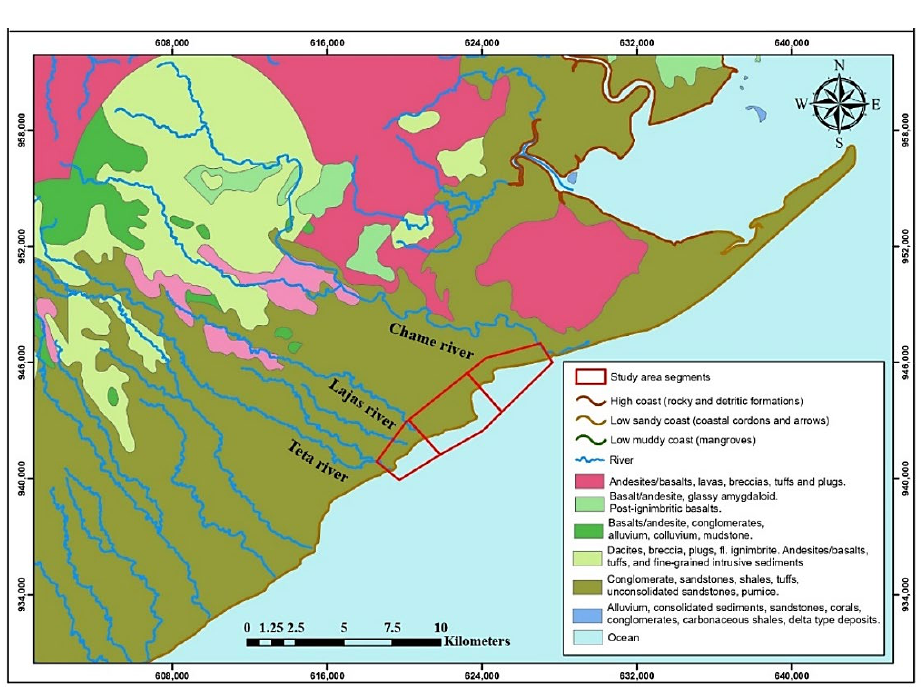
Figure 2. Geological, hydrological, and coast of study zones. Cartography made by Smithsonian Tropical Research Institute.